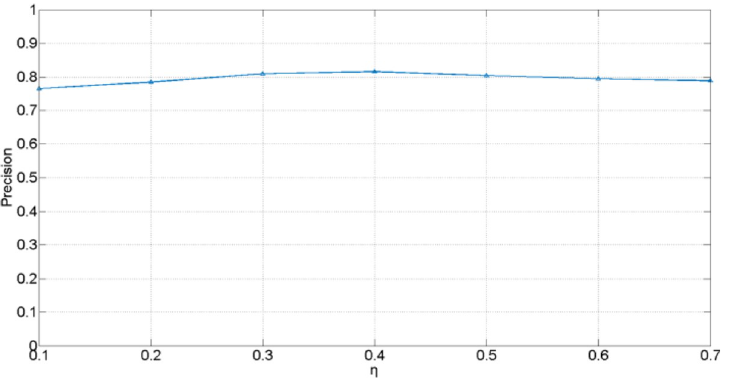
Fig 3. Evaluation of η based on